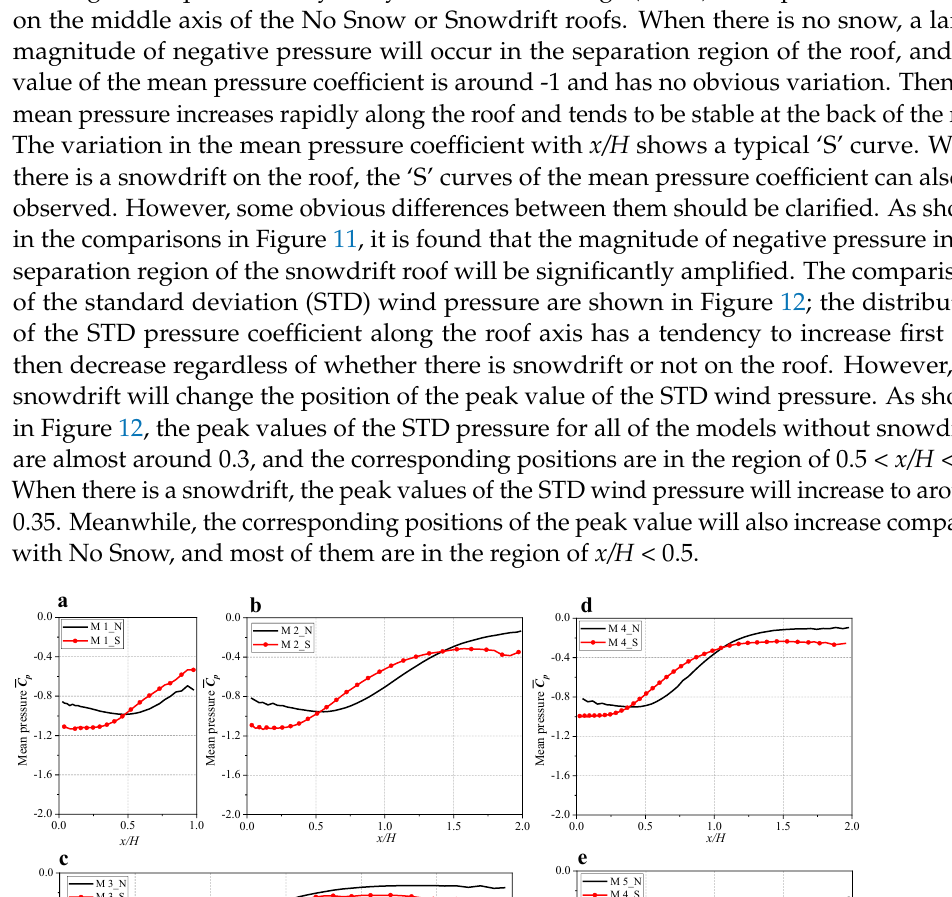
Figure 12. The distributions of fluctuating pressure coefficient ( 𝐶 𝑃′ ) along the roof axis (( a ) M1; ( b ) M2; ( c ) M3; ( d ) M3; ( e ) M4).